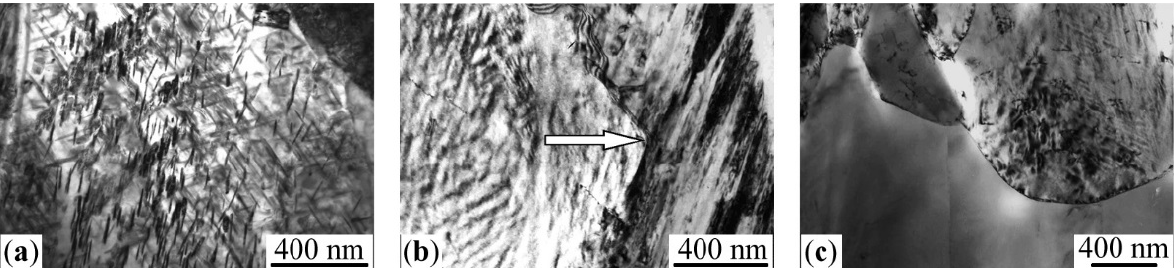
Figure 3. The structure of FeNi 31.1 alloy formed during α → γ transformation under the heating at the rate of 0.2 K/min: ( a ) up to 430 °C; ( b ) up to 490 °C, an arrow indicates the growth direction of the globular austenite; ( c ) up to 520 °C.